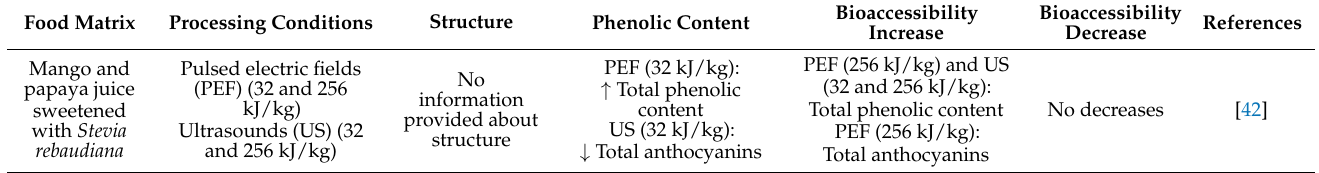
Table 2. Phenolic content, bioaccessibility, and structure of selected plant foods as affected by non-thermal processes. Food